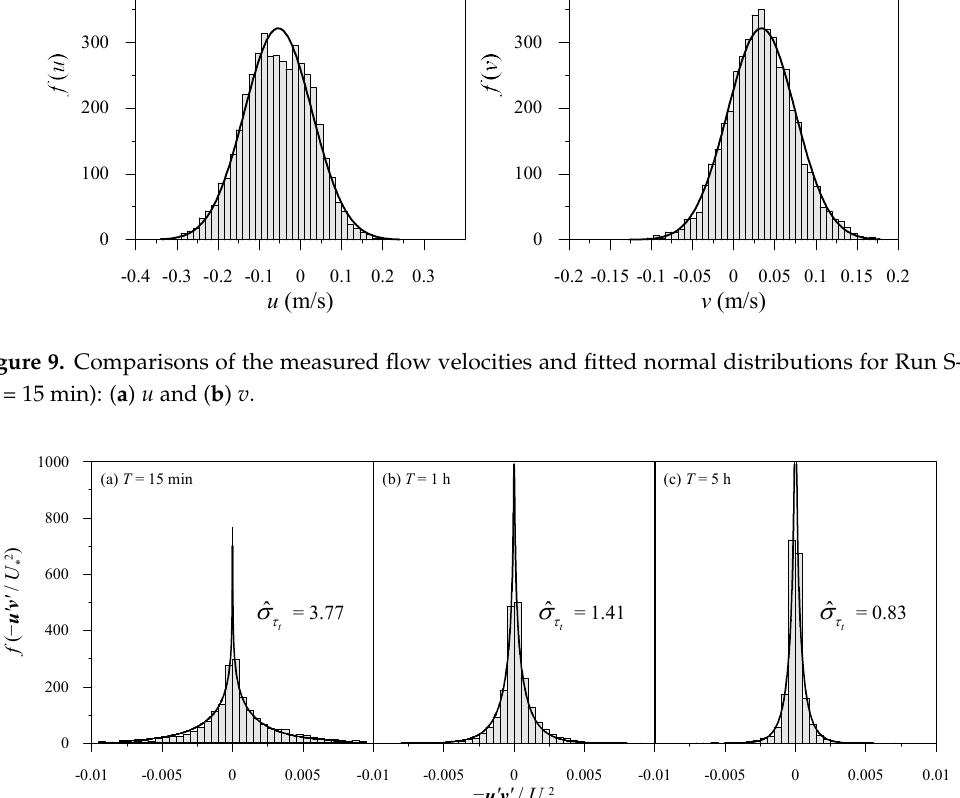
U u v and fitted * U u v and fitted * τ ) and standard deviation ( ˆ σ ) of t t τ τ ) and standard deviation ( ˆ σ ) of t t τ